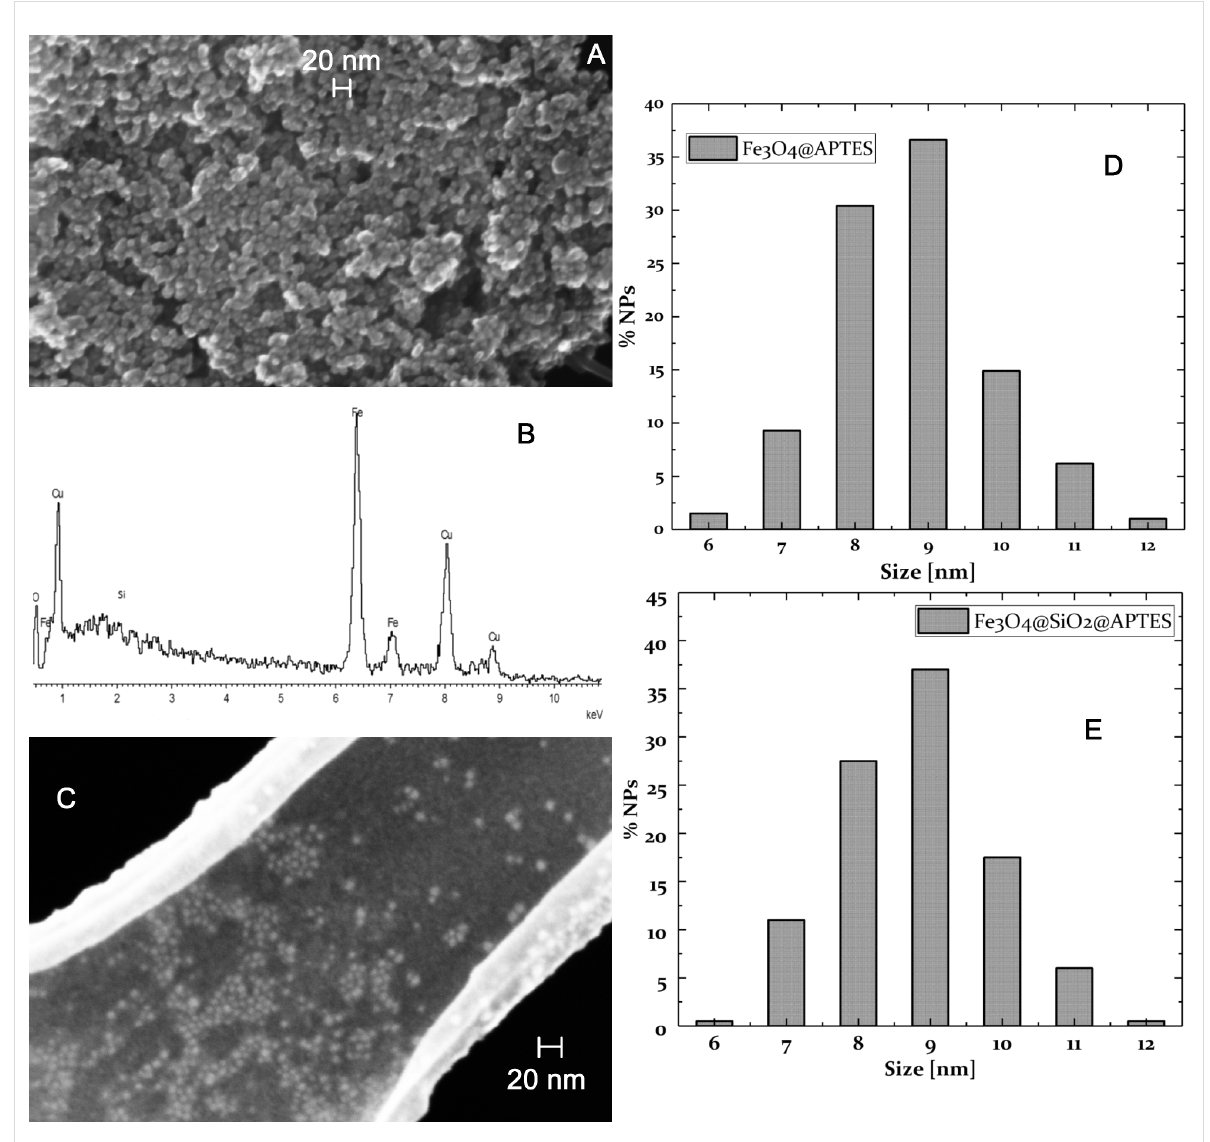
Figure 1: A) FE-SEM image of NP@APTES. B) EDX spectrum of NP@APTES. C) FE-SEM image of NP@silica@APTES. D) The diameter distribu- tion of NP@APTES from ≈ 200 NPs. E) The diameter distribution of NP@silica@APTES from ≈ 200